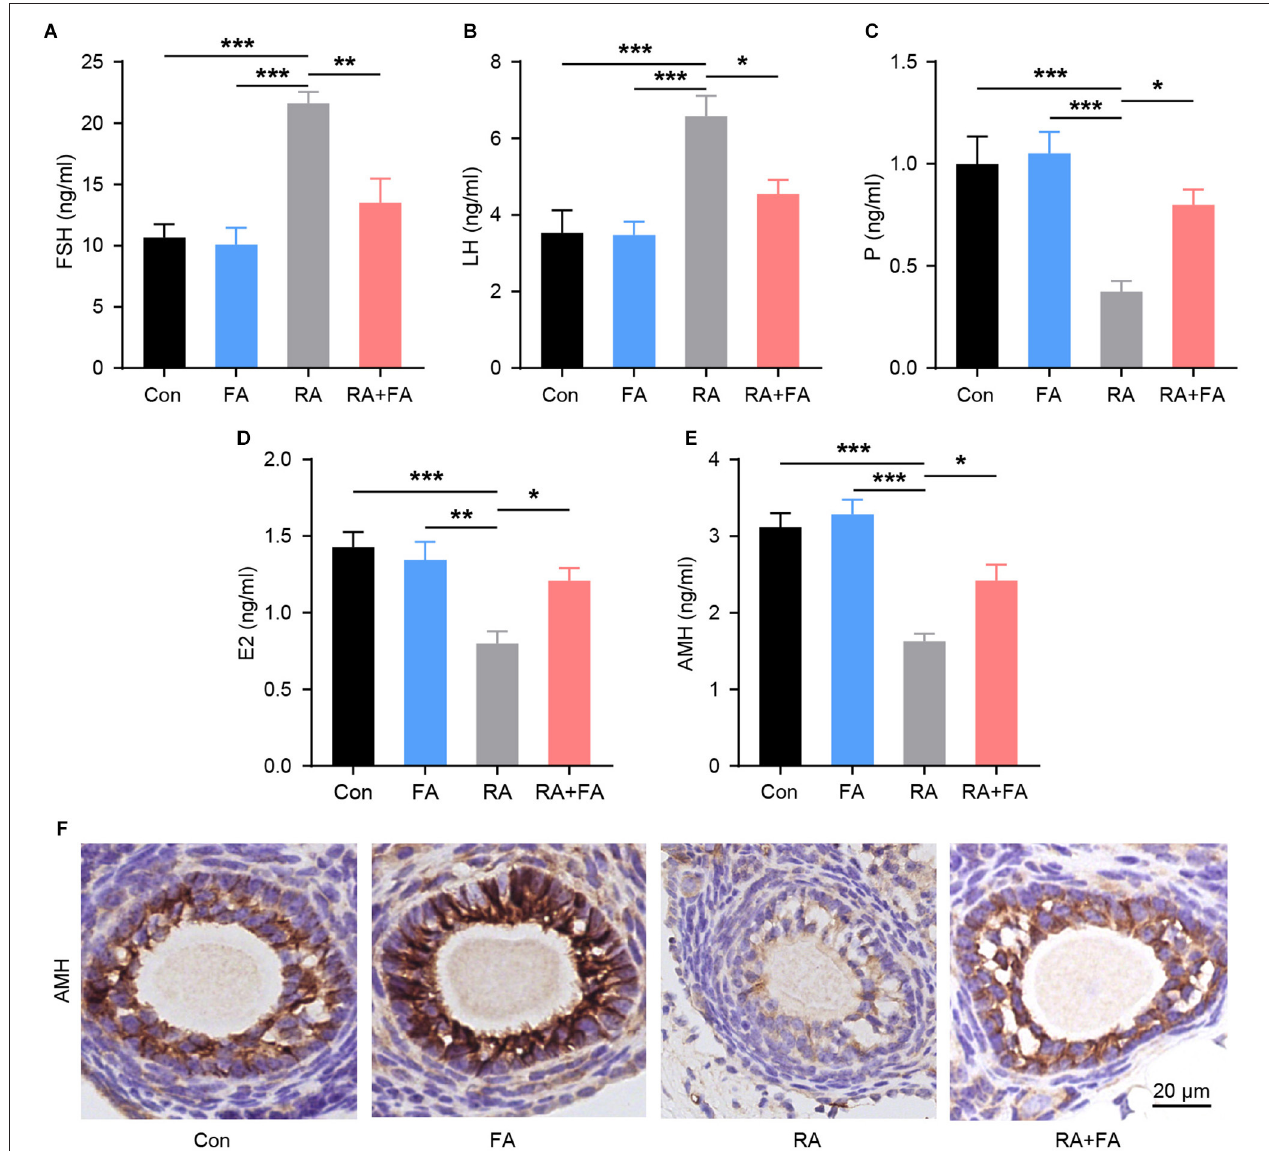
FIGURE 3 | Radiation-induced dysregulation of reproductive hormone secretion was alleviated via folic acid (FA) pre-administration. (A–E) Effect of FA pre-administration on serum FSH, LH, P, E2, and AMH levels determined via ELISA. FSH, follicle-stimulating hormone; LH, luteinizing hormone; P, progesterone; E2, estradiol; AMH, anti-Mullerian hormone. Each ELISA assay was repeated three times. (F) Immunohistochemical staining for AMH in ovarian follicles of each group. Con, control group; FA, FA pre-administration control group; RA, radiation exposure group; RA + FA, FA pretreatment + radiation exposure group. Scale bar, 20 µ m. Error bars, standard error of mean (SEM). N = 7–8, * p < 0.05, ** p < 0.01, and *** p < 0.001.